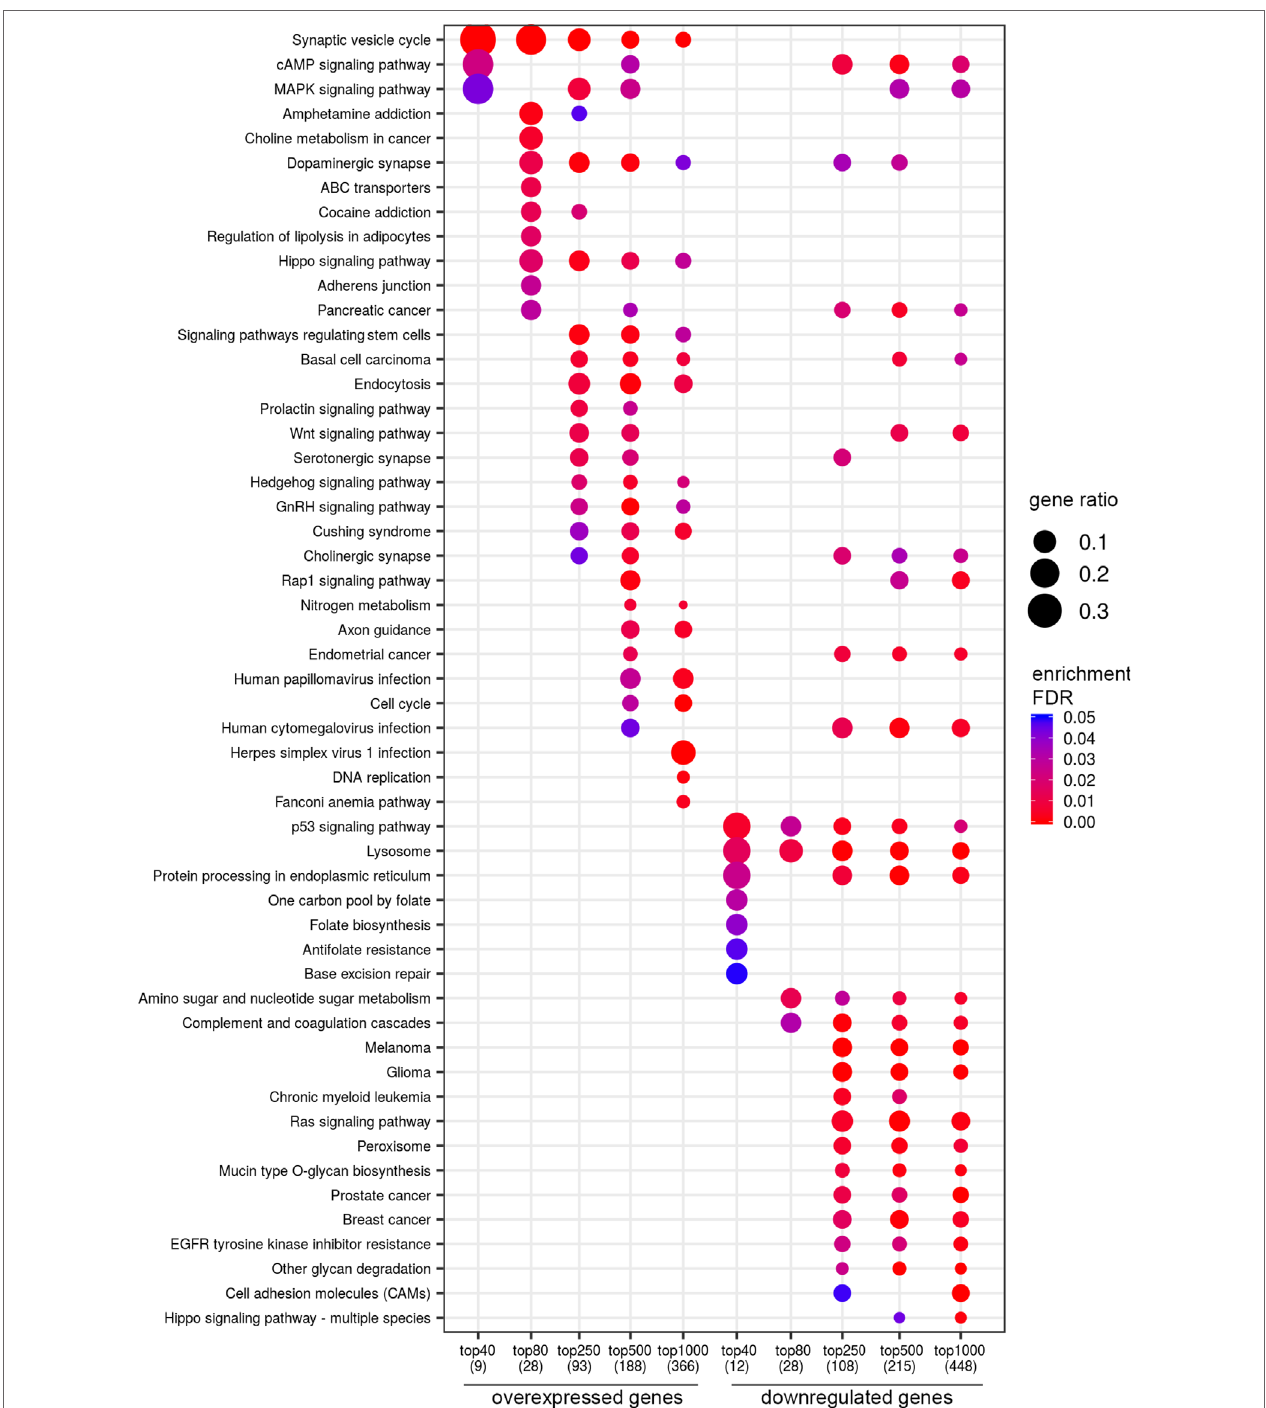
FIGURE 5 | Dotplot showing the results of KEGG pathways enrichment analyses performed for top-40, 80, 250, 500, and 1,000 differentially expressed genes (either overexpressed or downregulated) between the groups of adverse and favorable prognosis (TCGA data; TMPRSS2-ERG-positive samples). All the genes have passed the following thresholds: DESeq p -value < 0.01, Mann–Whitney p -value < 0.05, average expression-level fold change > 25%. Dot size indicates k / n ratio (“gene ratio”), where k is the number of genes participating in the current KEGG pathway (within top-40, top-80, or other top lists), and n is the number of genes (also within top-40, top-80, or other top lists) annotated as participants of any KEGG pathway (these numbers are provided in the brackets in the bottom of the figure). Dot color indicates the enrichment test FDR (Fisher’s exact